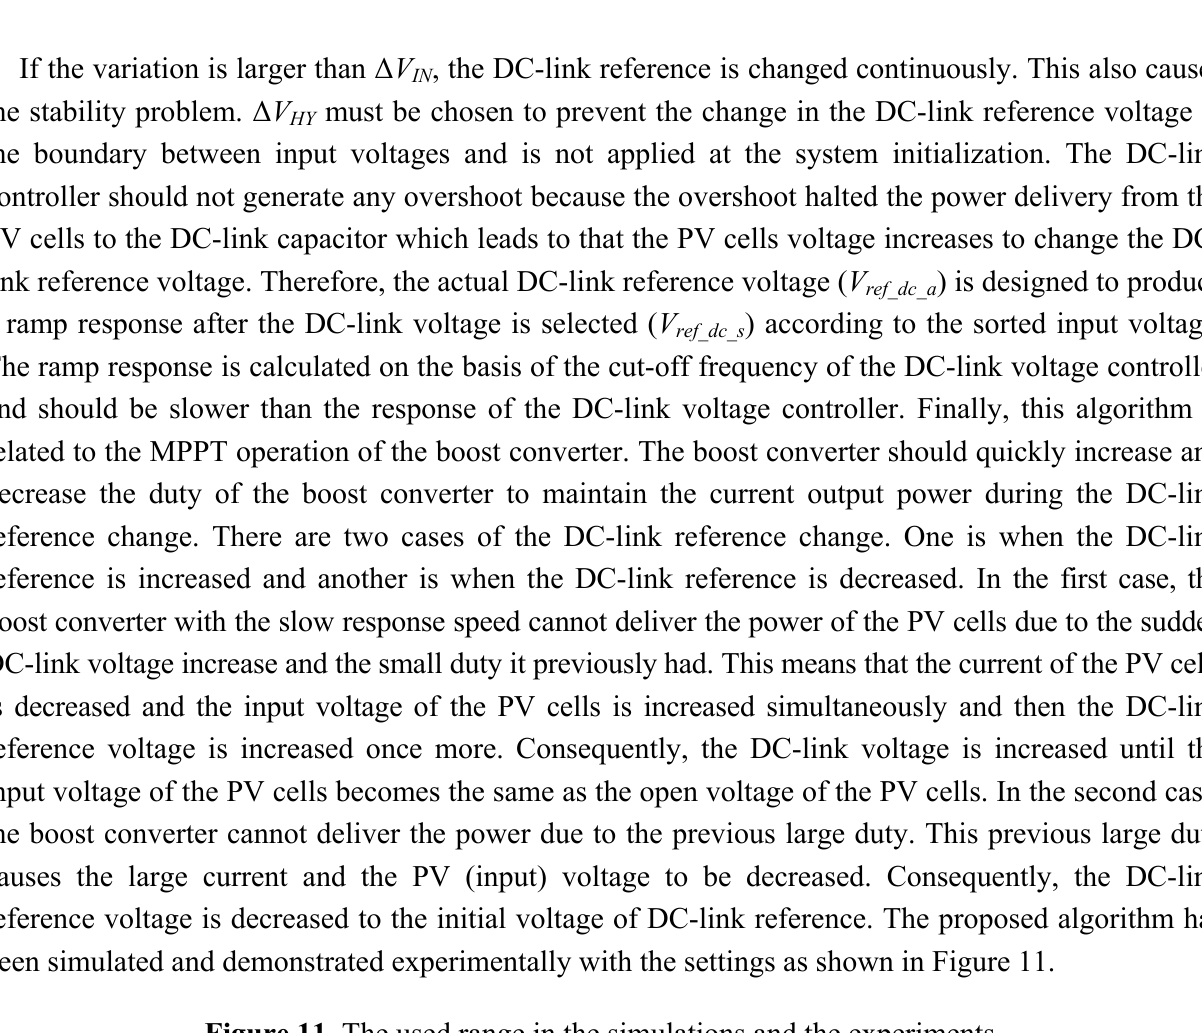
Figure 11. The used range in the simulations and the